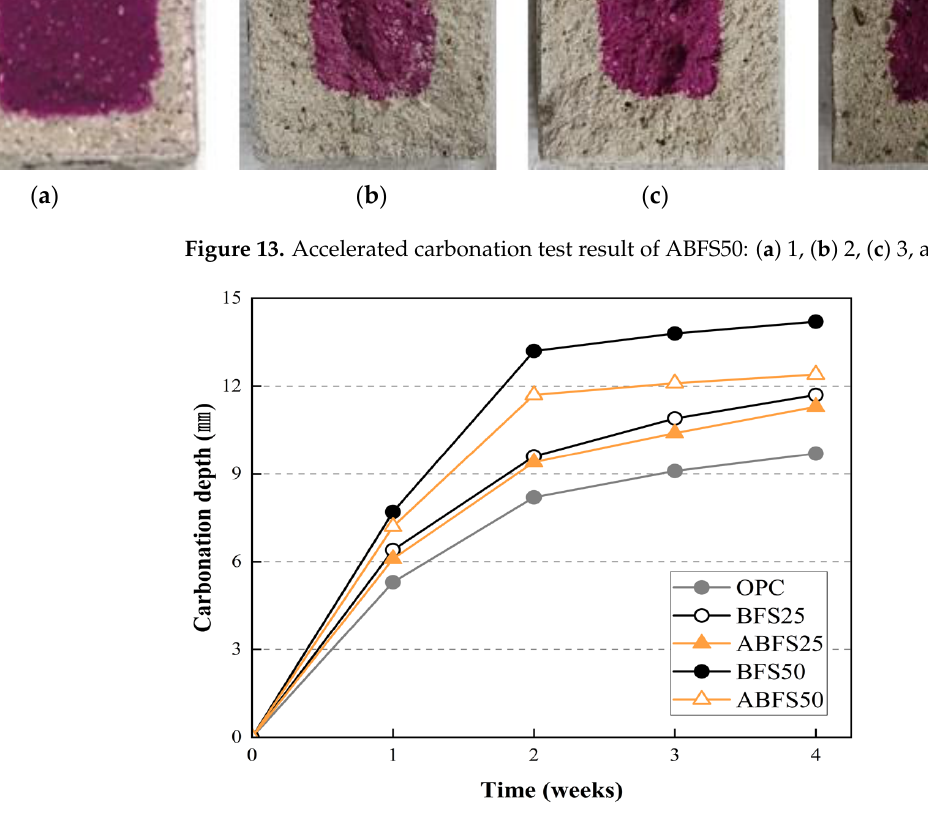
Figure 14. Carbonation depth measurement results.